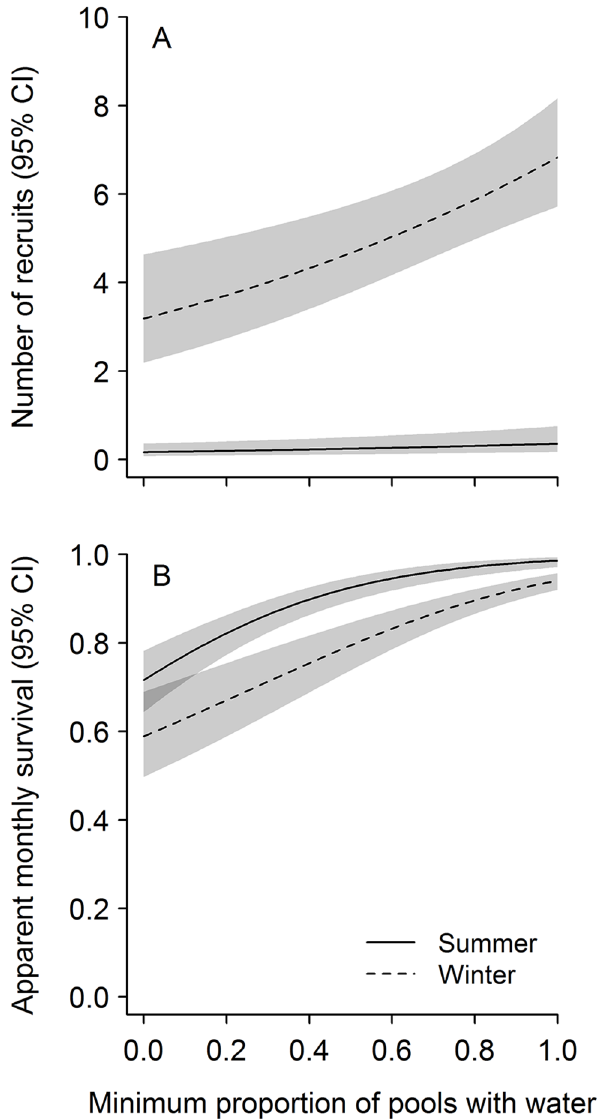
Fig 1. Predicted number of recruits and monthly survival of adult lowland leopard frogs as a function of seasonal water availability between 1996 and 2011 in the Rincon Mountains, Arizona, USA. Predicted number of recruits into the adult stage class for an average-sized pool complex (A) and monthly survival (B) with 95% confidence intervals. We made predictions from a model of recruitment as a function of season, seasonal water availability, number of pools per complex, and connectivity, and a model of survival as a function of season and seasonal water availability (Table 2). To predict the number of recruits, we held the number of pools per complex and connectivity values at the mean observed across all pool complexes (5 and 0.24,